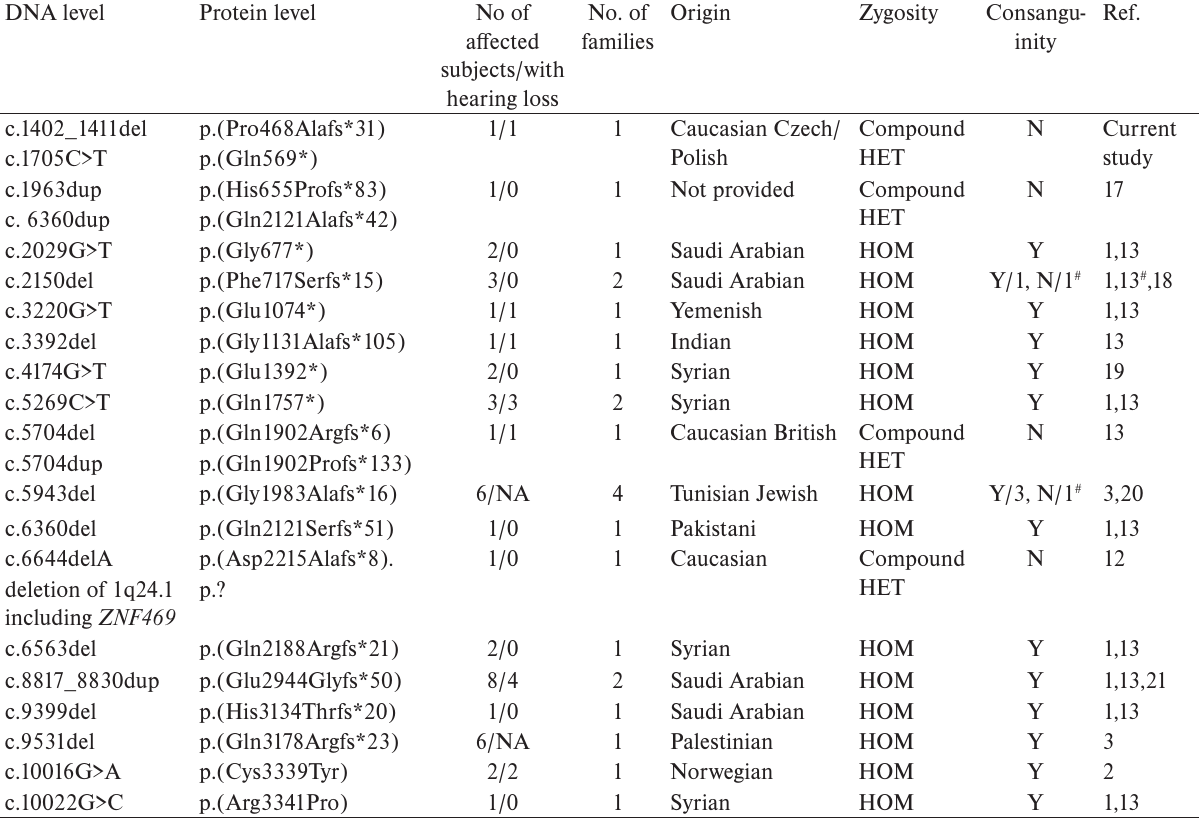
table 2. Summary of ZNF469 mutations and individual families with brittle cornea syndrome reported to date. DNA level